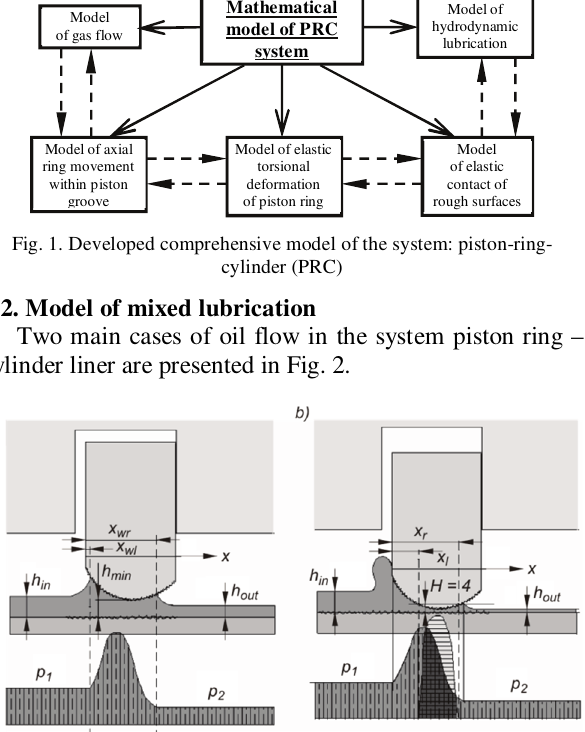
Fig. 2. Scheme of gap between the ring face and cylinder liner in the case of: a) fluid and b) mixed